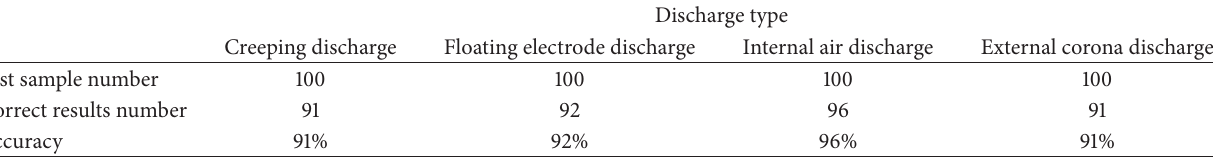
Table 11: Results of multi-SVM.